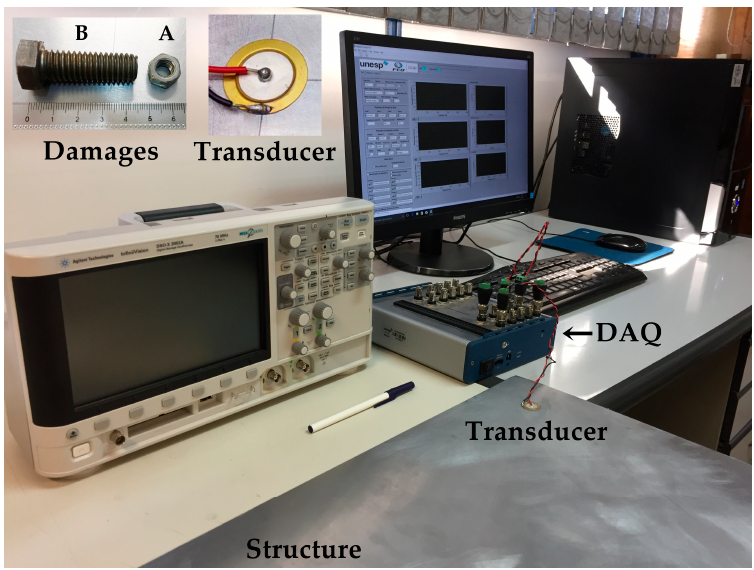
Figure 2. Experimental